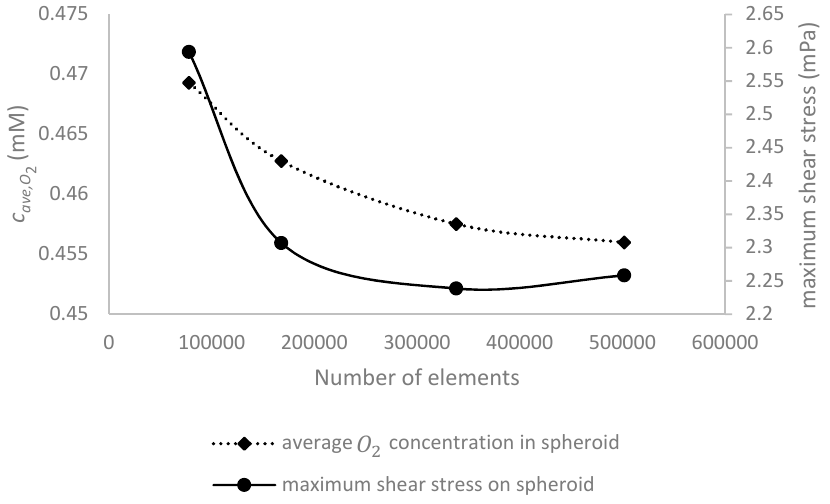
Figure 2. Finite element convergence and grid independence verification on the simulated results. The average oxygen concentration inside the spheroid (the left vertical axis) and maximum shear stress on its surface (the right vertical axis) are plotted as a function of the number of computational elements. The simulations were performed with D = 500 μ m, Q = 5 μ L/min and (cid:1855) (cid:2868),(cid:3016)